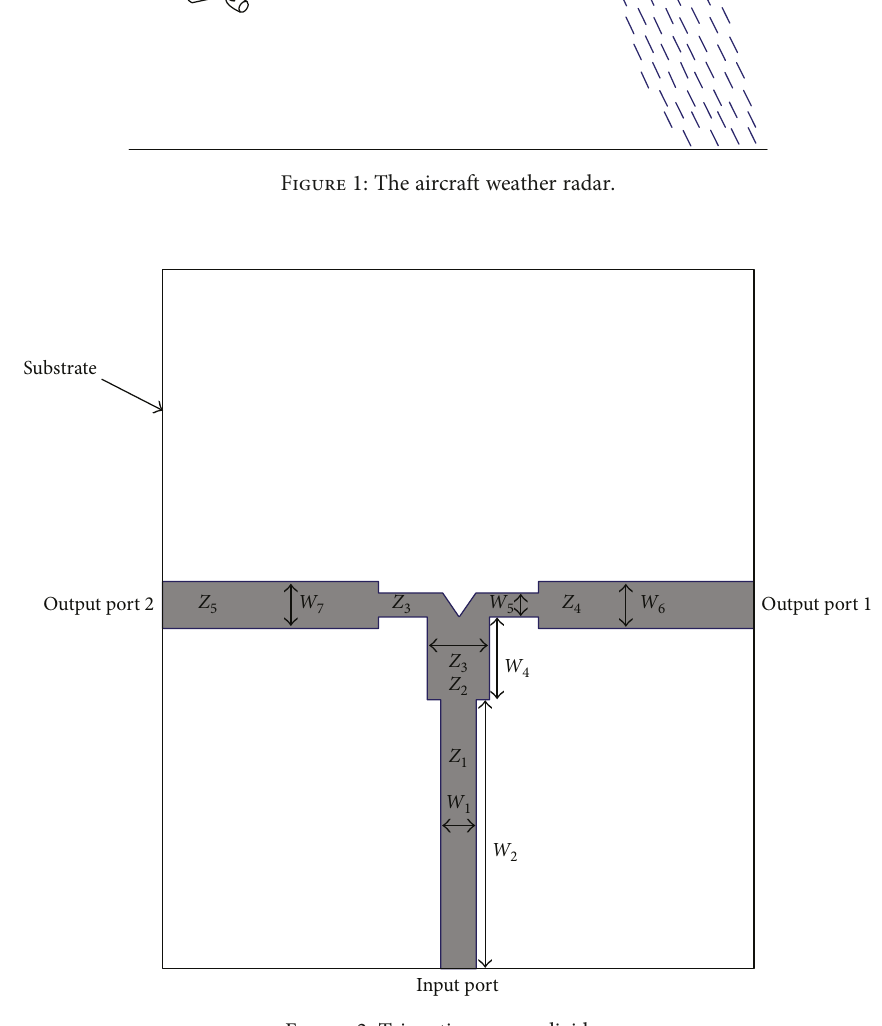
Figure 2: T-junction power divider.